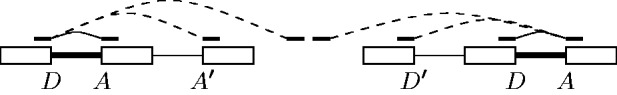
Left: the 5′-splicing
index, , is the number of reads supporting the
splicing event from  to  relative to the combined number of reads supporting splicing
from  to any acceptor site
. Right: the 3′-splicing index,
, is the number of reads supporting the
splicing event from  to  relative to the combined number of reads supporting splicing
from any donor site  to . The intron of interest is drawn thick